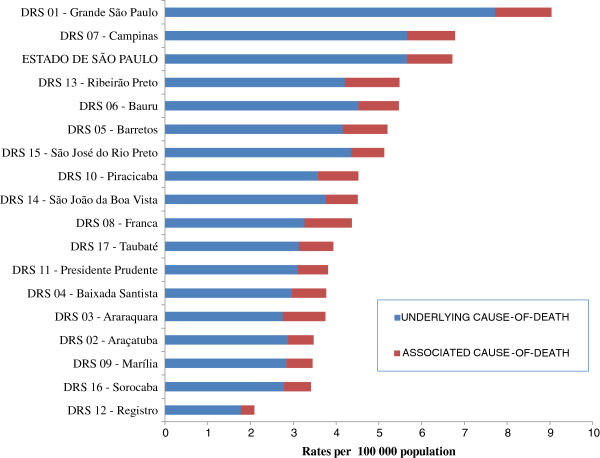
Age-standardized death rates related to aortic aneurysm and dissection according to Regional Health Directions, state of São Paulo, averaged from 1985 to 2009.